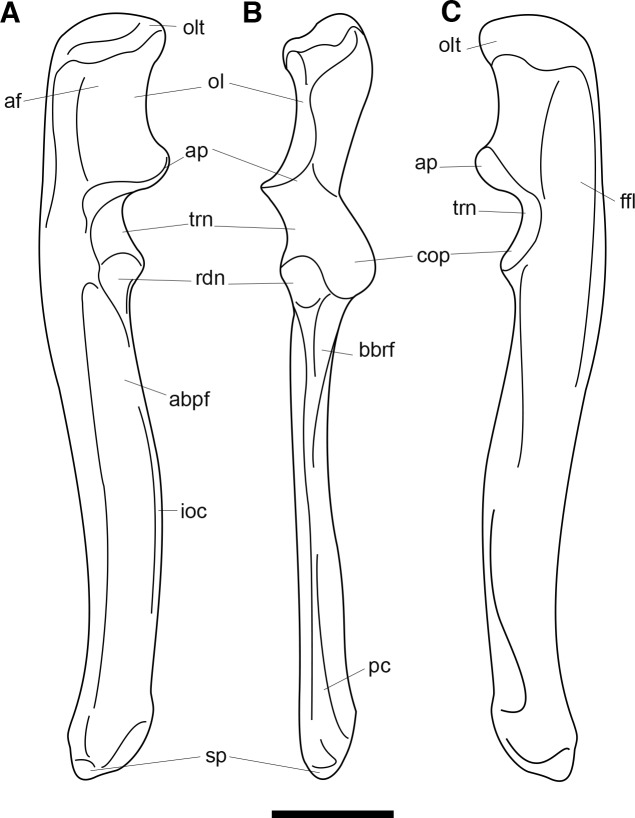
Annotated line drawing of the right ulna of Periptychus carinidens.(A) lateral view; (B) anterior view; (C) medial view. Abbreviations abpf, abductor pollicis longus fossa; af, anconeal fossa; ap, anconeal process; bbrf, biceps and brachialis fossa; cop, coracoid process; ffl, flexor fossa; ioc, interosseous crest; ol, olecranon; olt, olecranon tuber; pc, pronator quadratus + teres crest; rdn, radial notch; sp, styloid process; trn, trochlear notch. Scale bar: 30mm.